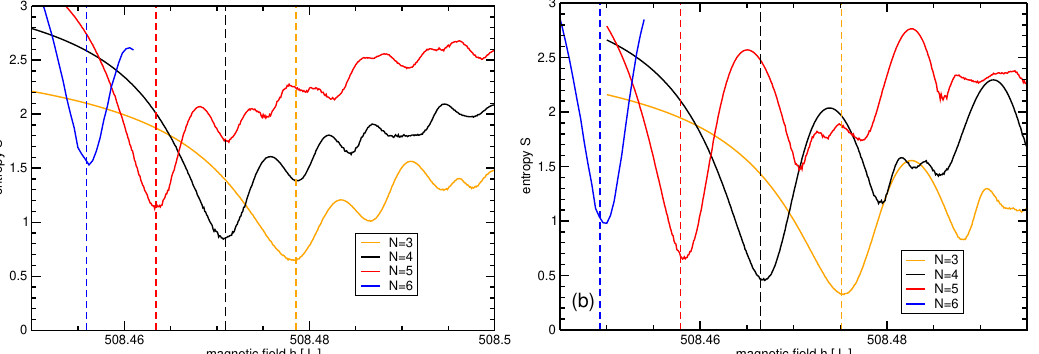
Figure 9: Residual entropy as function of the applied magnetic field for various bath sizes N for the Gaussian distributed couplings given by (10); panel (a) for α = 1 and panel (b) for α = 0.5 and hence smaller ratio J